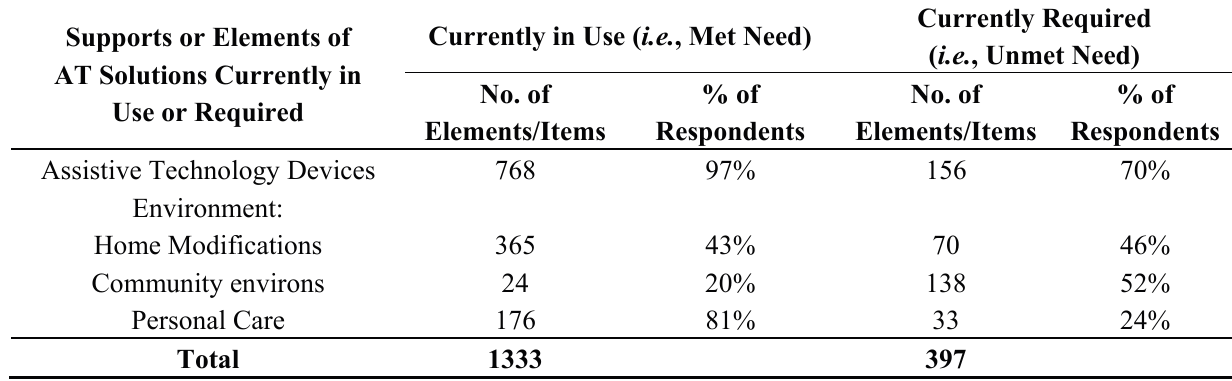
Table 2. Number of supports used or required by participants (N-100).